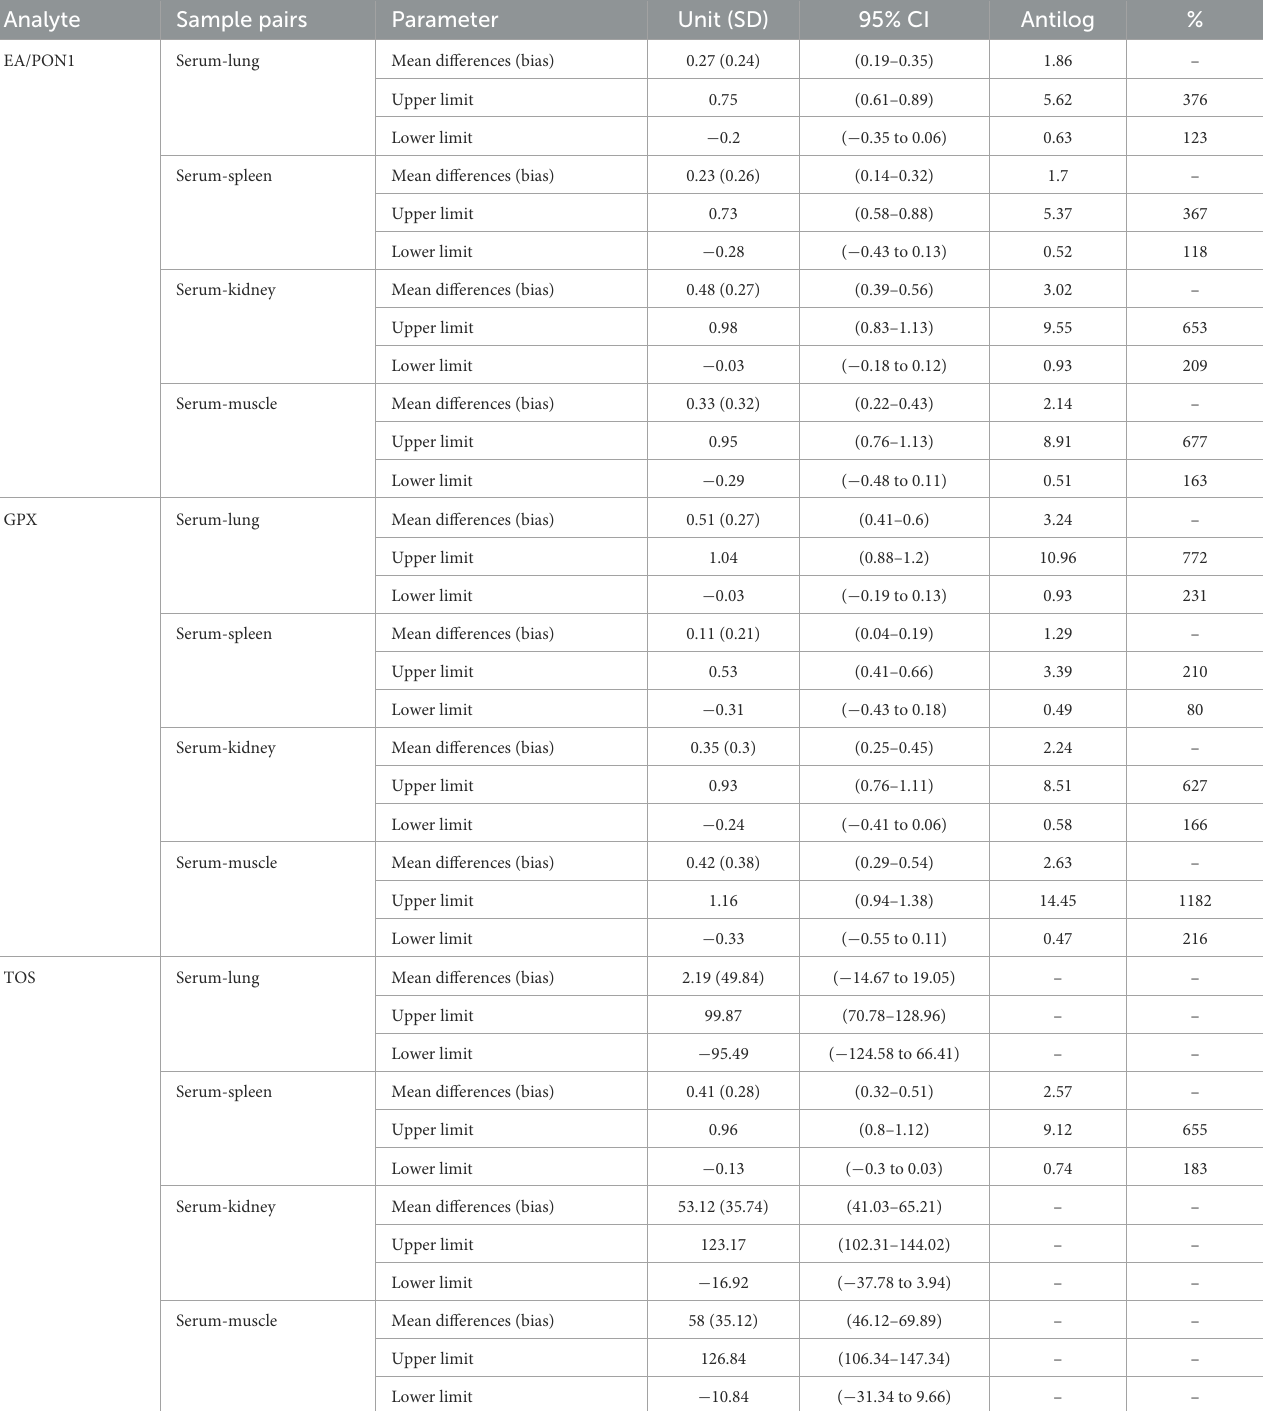
TABLE 1 Descriptive statistics for the Bland Altman analysis of selected oxidative stress biomarkers: p-nitrophenyl esterase activity (EA)/paraxonase 1 (PON1), glutathione peroxidase (GPX), and total oxidative status (TOS) simultaneously measured in serum, lung, spleen, kidney, and muscle from 63 wild boar hunter-harvested in Toledo, Central